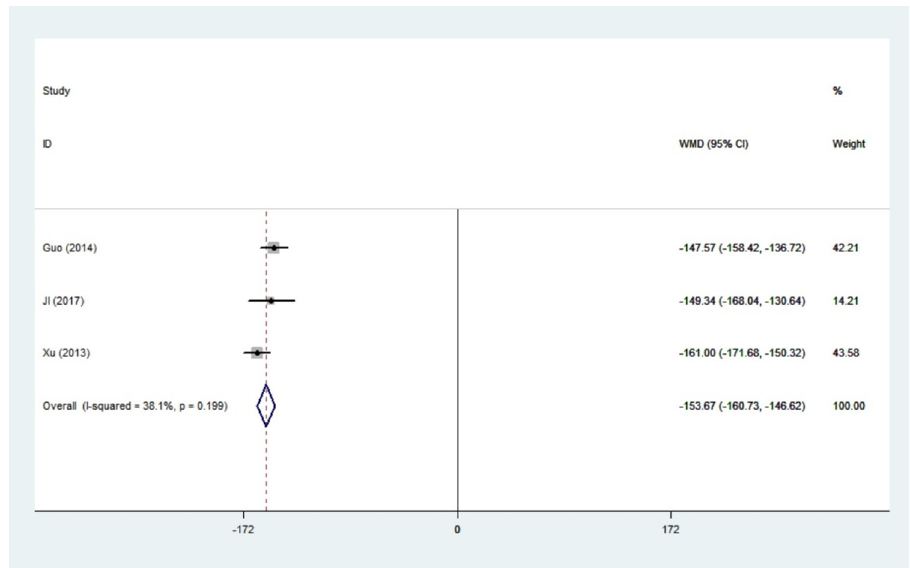
Fig 10. Forest plots of showing the effects of PTU on TT4.